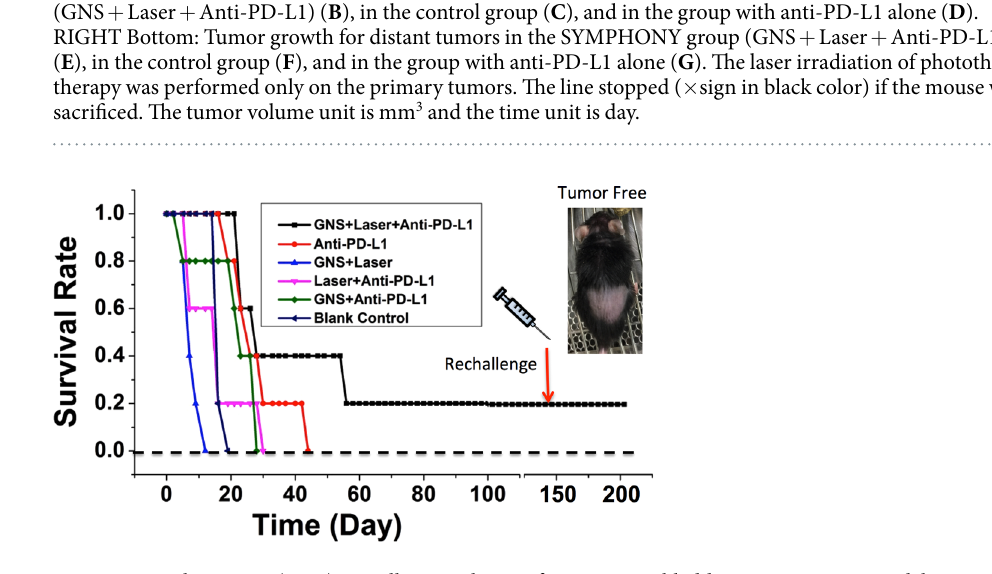
Figure 3. Kaplan-Meier (K-M) overall survival curve for aggressive bladder cancer murine models. GNS (2 mg per mouse) was intravenously (IV) injected through tail vein on Day 0 and laser treatment (808 nm, 0.6 W/ cm 2 ) was performed on Day 1. Anti-PD-L1 antibody was intraperitoneally (IP) injected every 3 days (200 μ g per injection). Only SYMPHONY group (GNS + Laser + Anti-PD-L1) has 2 survival mice (40%) at the end of 49 days. As of today ( > 200 days) one mouse (20%) is deemed cured even after a rechallenge experiment on day 145. All control groups have no survival mouse on day